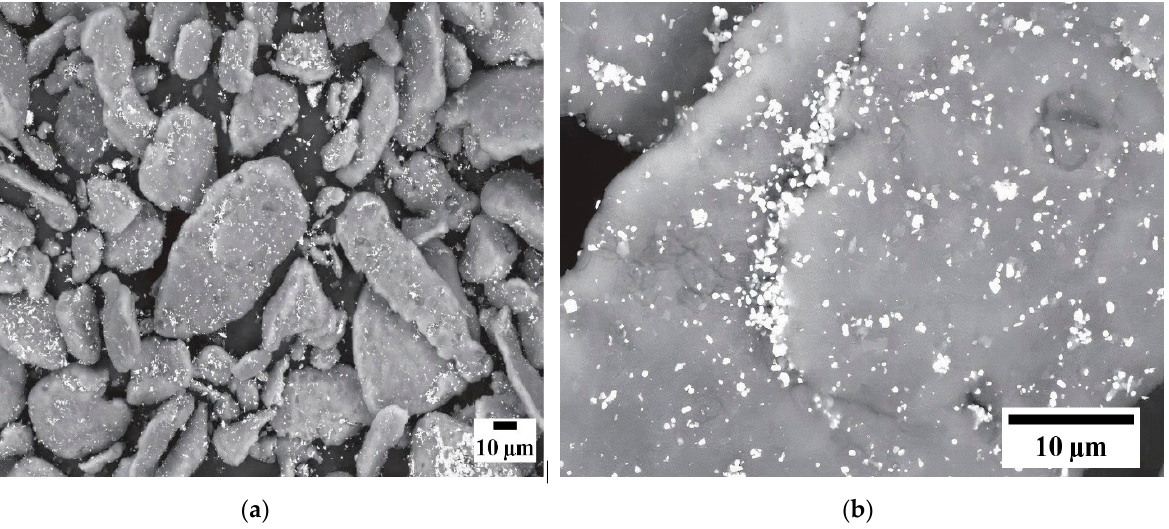
Figure 1. SEM micrographs (backscattered electrons signal) of the Mg-Ni-Nb 2 O 5 mixture after mild milling processing. Bright particles correspond to Ni and Nb 2 O 5 , while the larger, gray particles correspond to Mg. ( a ) Low magnification image showing overall dispersion of Ni and Nb 2 O 5 parti- cles on the surface of the Mg powders. ( b ) Image at higher magnification in which individual and agglomerated Ni and Nb 2 O 5 particles can be observed more clearly. Figure 2 is a schematic diagram of the processing route of the as-milled powders. In